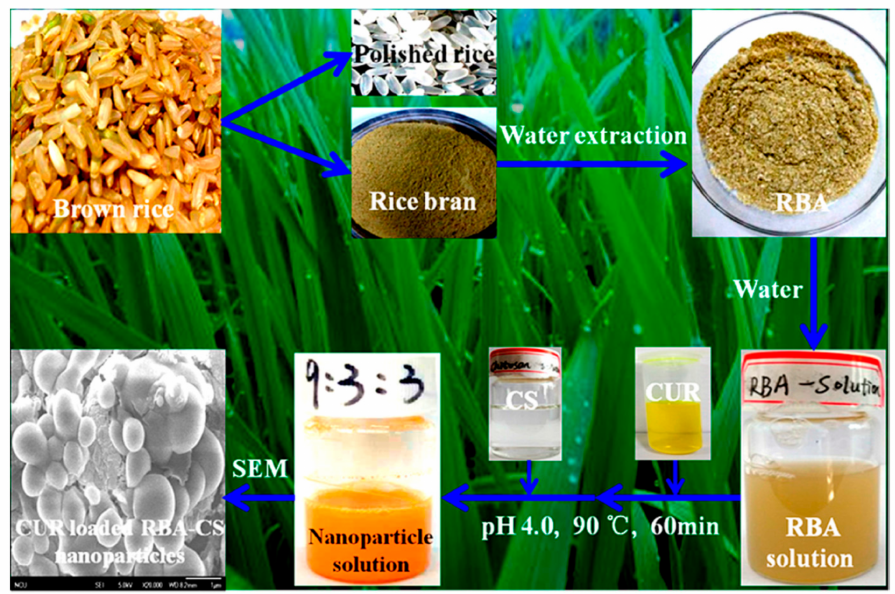
Figure 21. Schematic representation of the process used for the preparation of rice bran albumin and chitosan blend nanoparticles as carriers for curcumin. Reprinted with permission from ref. [135]. Copyright 2017 American Chemical